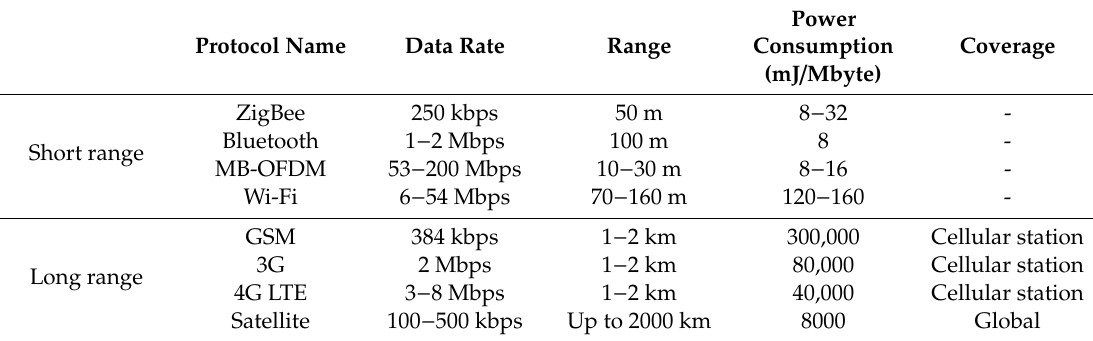
Table 1. Summary of wireless